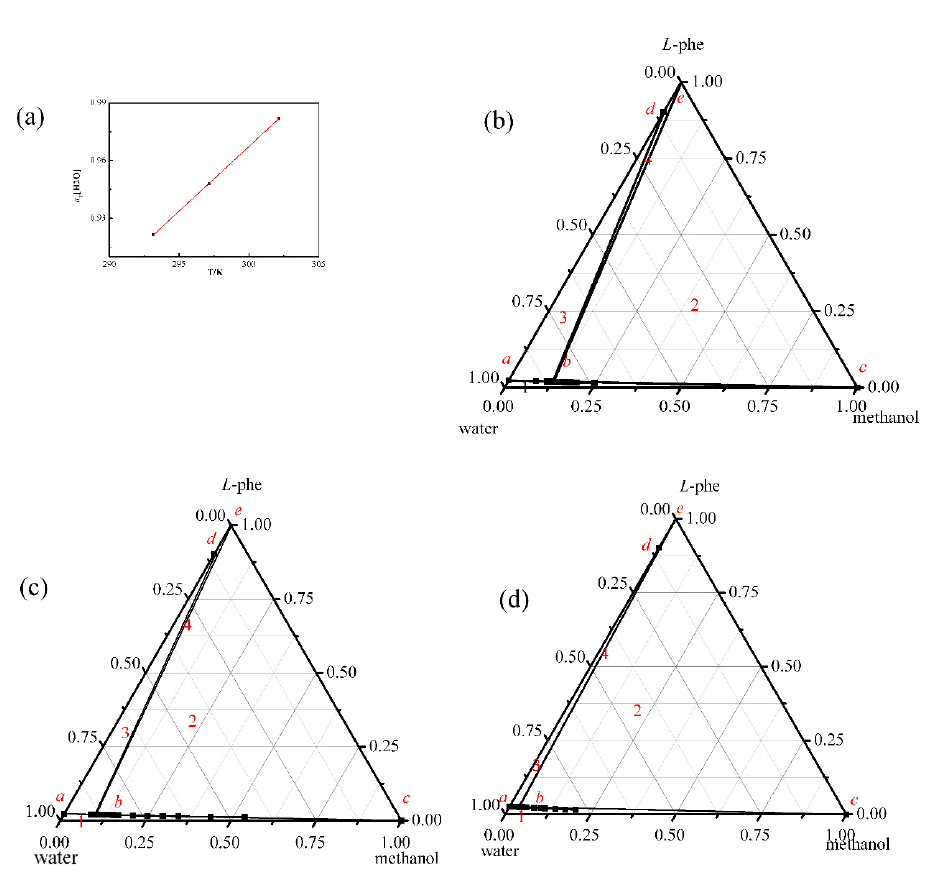
Figure 4. ( a ) Equilibrium water activity as a function of temperature; ternary phase diagram of methanol-L-Phe-water at temperature 293.15 K ( b ), 297.15 K ( c ) and ( d ) 307.15